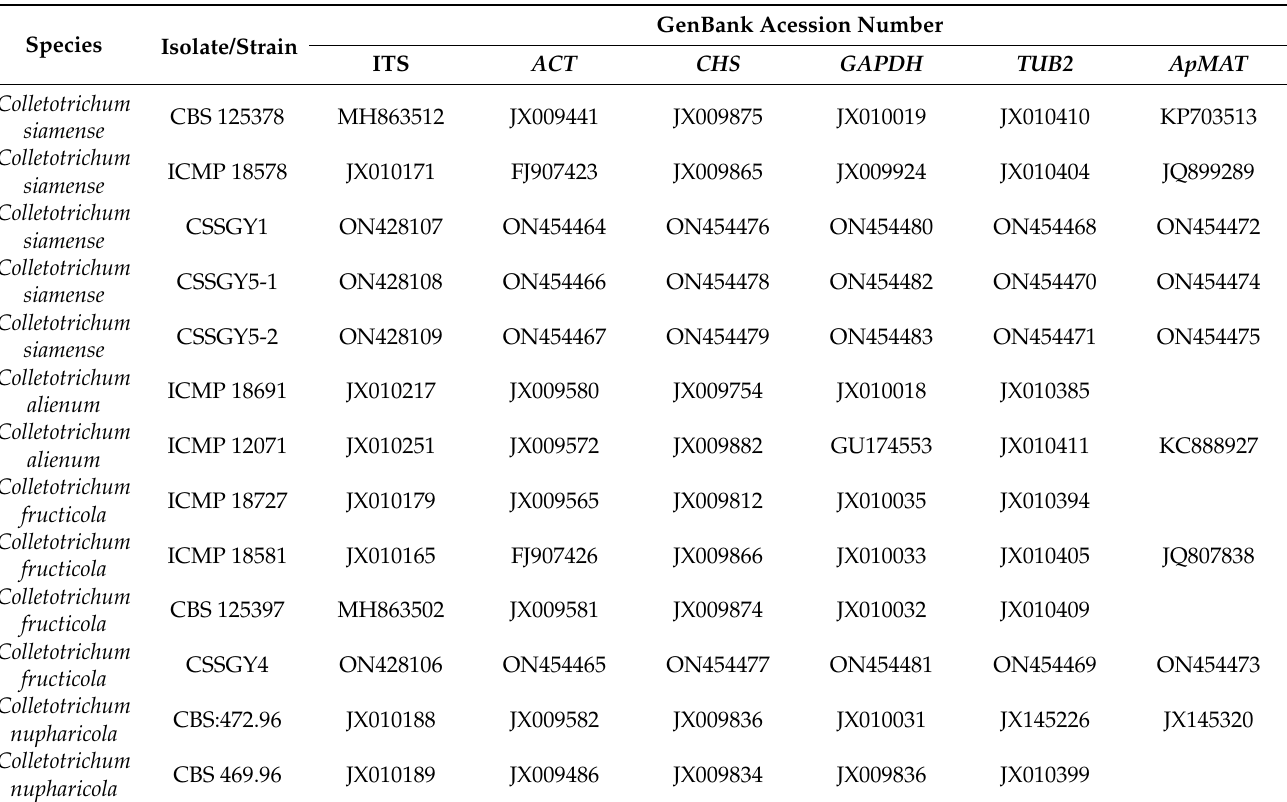
Table 3. Information on the GenBank accession numbers of the Colletotrichum species used for phylogenetic